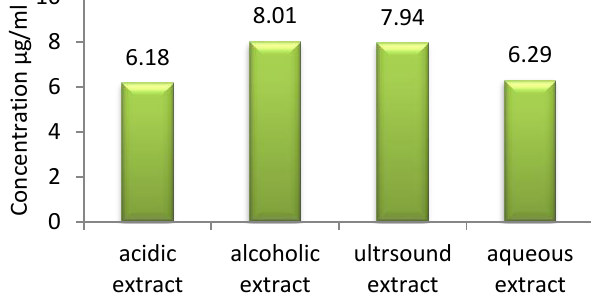
Figure 7. Berberine content.